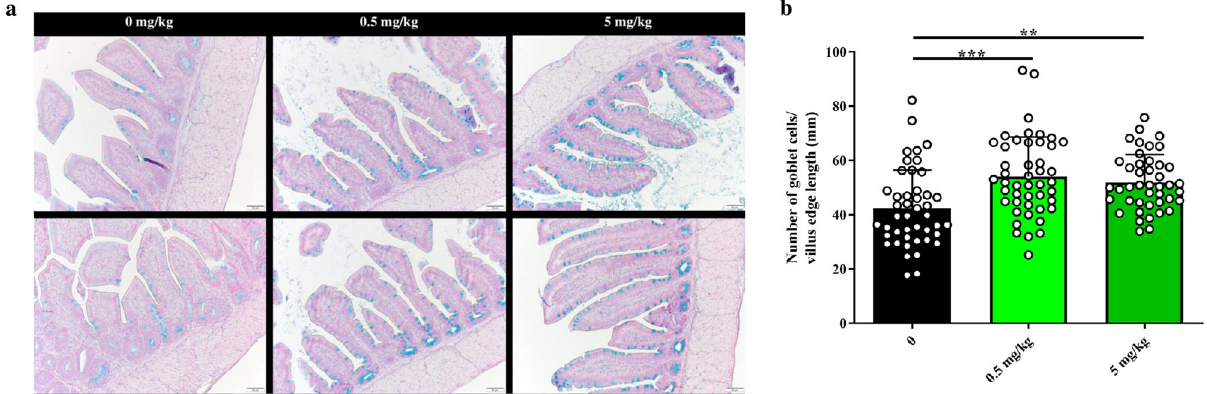
Fig. 3 Reserpine treatment increases goblet cell numbers in the chicken ceca. Representative images of Alcian blue staining in ceca tissues ( a ). Total calculations of goblet cells/villus edge length (mm) ( b ). Scale is indicated by white bar (bottom right corner per image; 50 µ m). Signi fi cant differences indicated by asterisks: ** P < 0.01; *** P < 0.001. Error bars indicate the standard deviation above and below the mean.